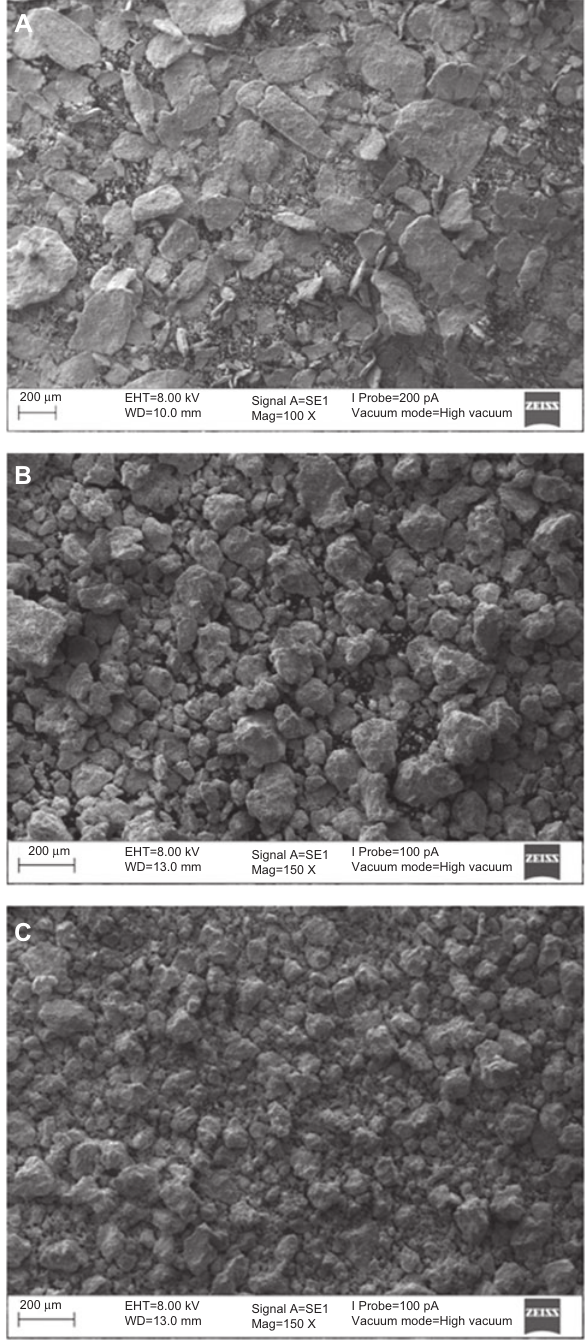
Figure 6 Morphology of Al-15 vol. % Al function of milling time: (A) 0.5 h, (B) 2 h, (C) 7